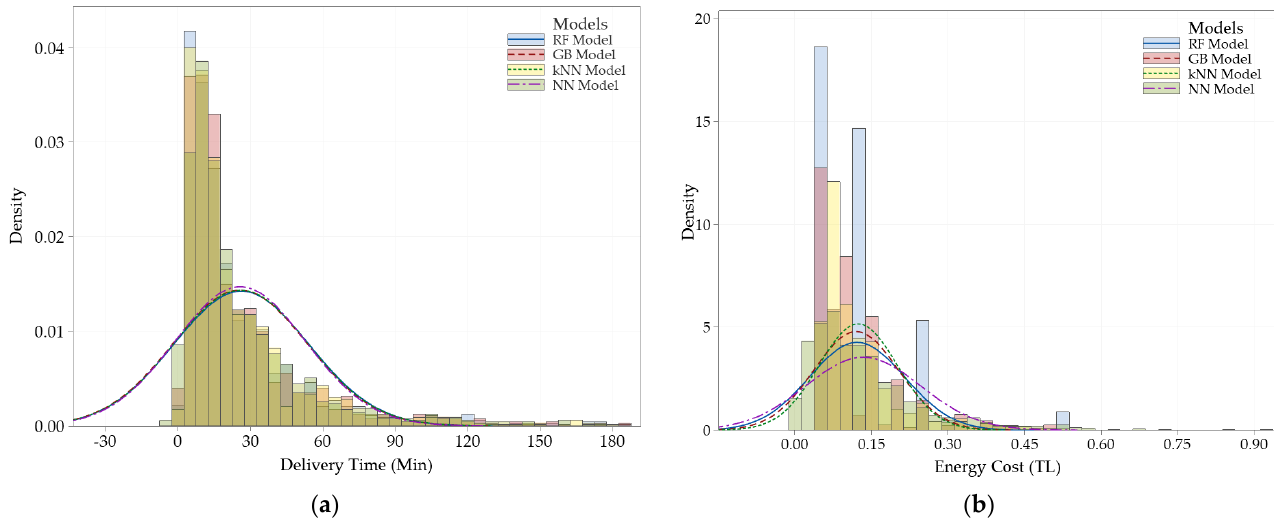
Figure 8. The comparison between actual and estimation data of ML algorithms: ( a ) delivery time; ( b ) delivery energy cost variable.